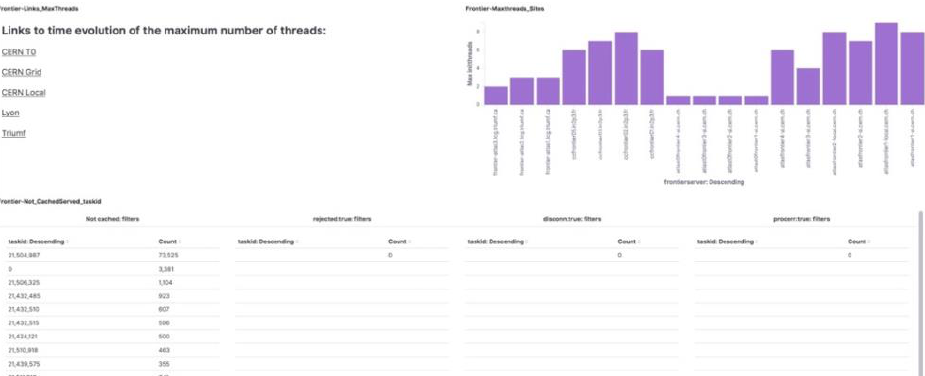
Fig. 1. Page from the Frontier Dashboard developed by the ES. This particular page contains relevant information about the number of queries/threads handled at the same time, number of queries not cached on Frontier squid servers according to task identification codes and links to other